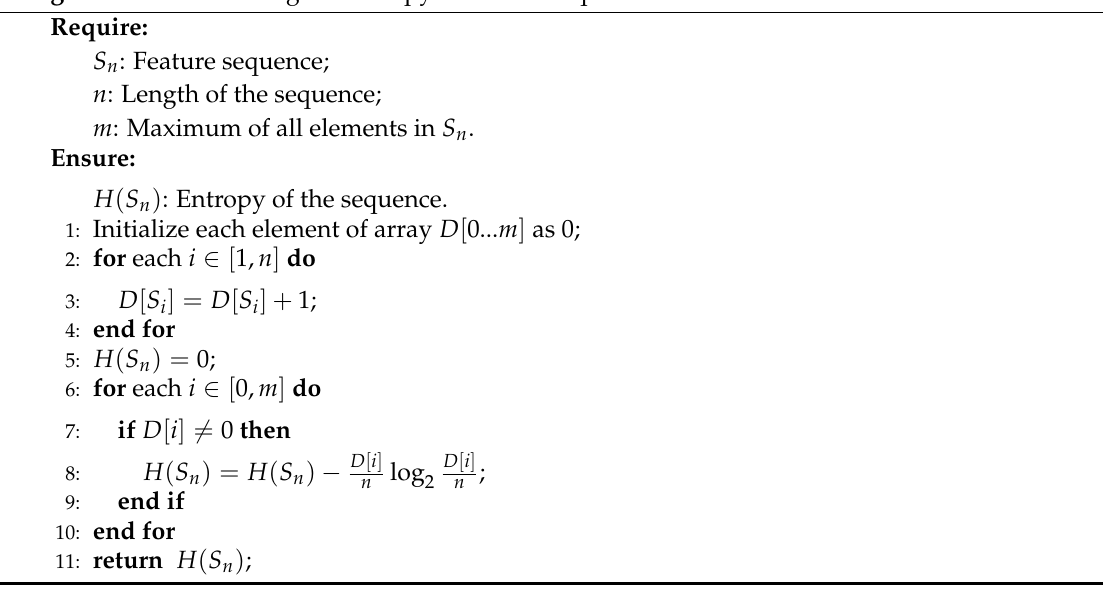
Algorithm 1: Calculating the entropy of feature